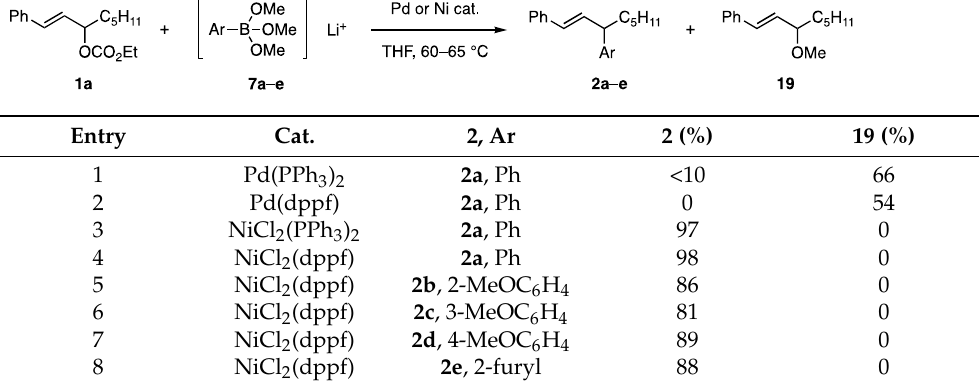
Table 1. Allylic substitution with aryl borates.